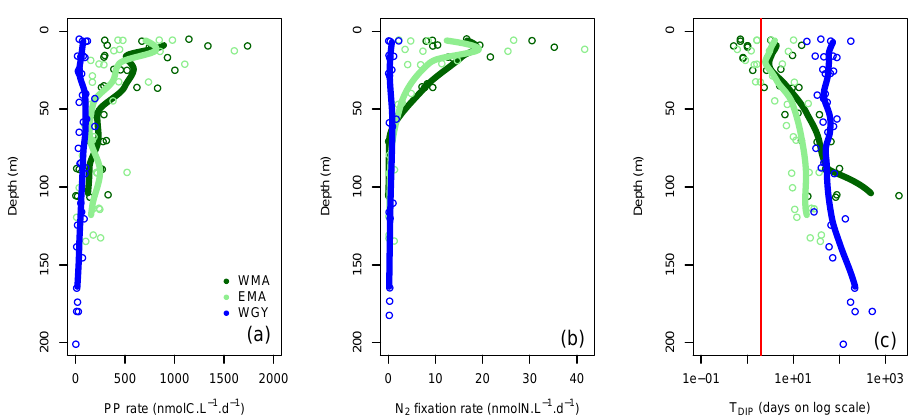
Figure 6. Vertical profiles of (a) primary production (PP rate in nmolCL − 1 d − 1 ) , (b) N 2 fixation rate (nmolNL − 1 d − 1 ) and dissolved inorganic phosphate turnover times ( T DIP in days on log scale) against depth for the three distinct areas sampled during the OUTPACE cruise: the western Melanesian Archipelago (WMA in dark green), the eastern Melanesian Archipelago (EMA in light green), and the western SP gyre (WGY in blue). The vertical red line indicates the critical DIP turnover time of 2